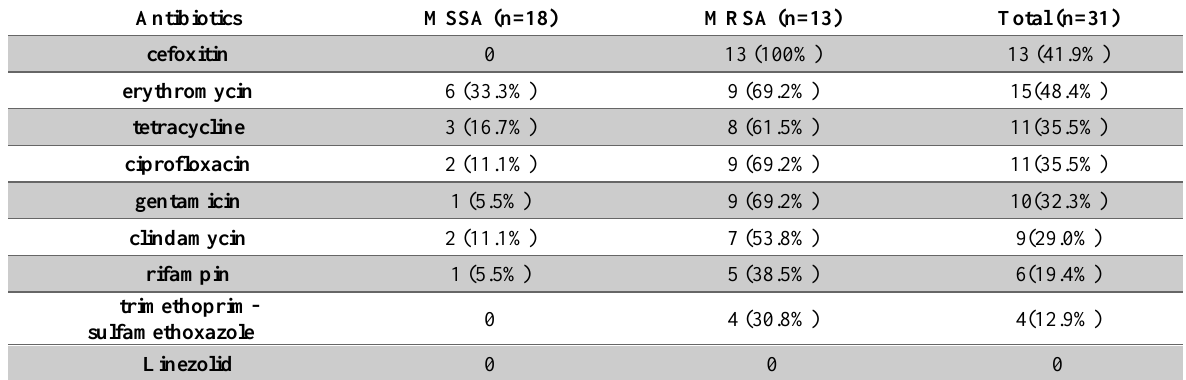
Table2. Antibiotic resistance of MSSA and MRSA isolated from burn patient